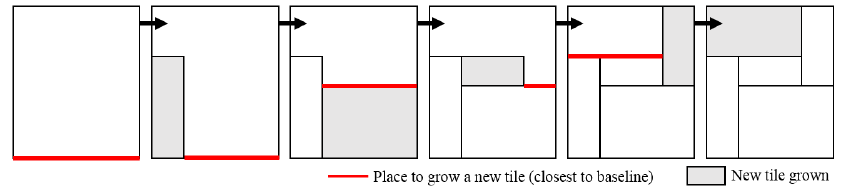
Figure 7. Dynamic-growth tiling: the baseline is the bottom side (grid lines are not